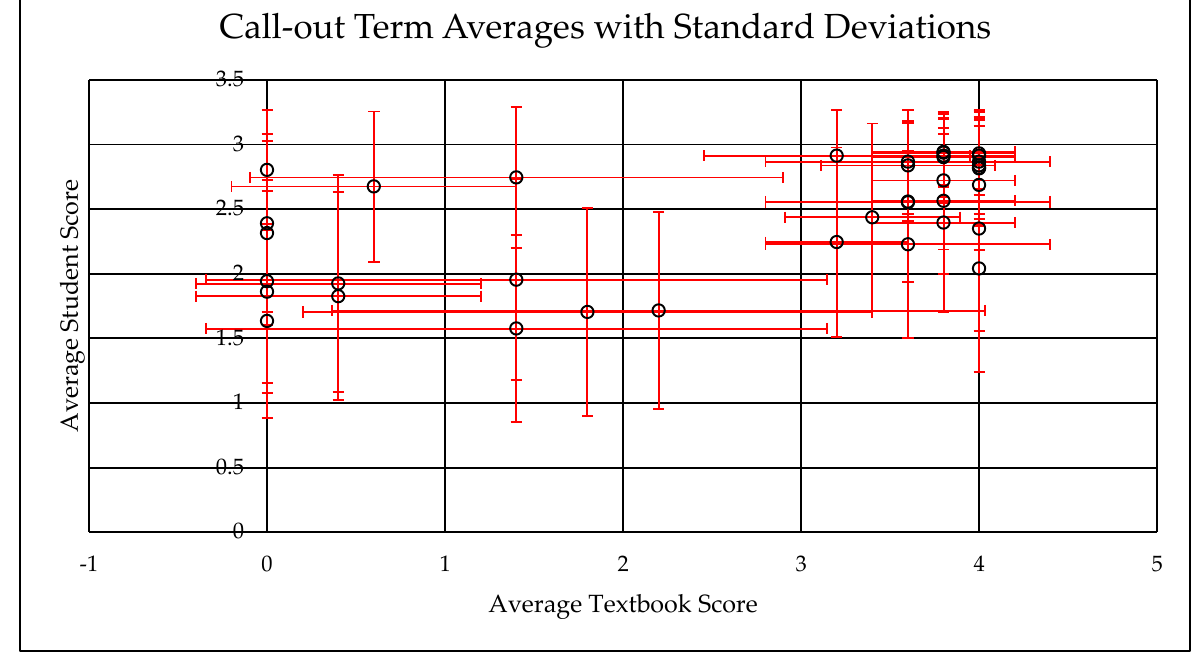
Figure 5. Depiction of the average score and standard deviation for each call-out term from the textbook and student surveys. High-scoring terms on textbook and student surveys had lower standard deviations than low-scoring terms. Additionally, terms that scored as 0 on the textbook survey scored 0 across the board (no standard deviation). The same was true for terms that scored 4 on the textbook survey. Overall the standard deviations stayed relatively low, with an average deviation of 0.499 for textbook surveys and 0.579 for student surveys.